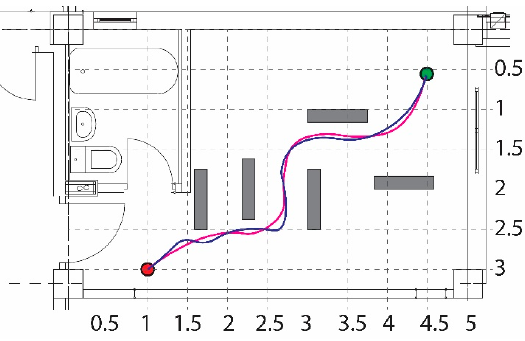
Figure 12. Obstacle avoidance in a corridor-like environment.